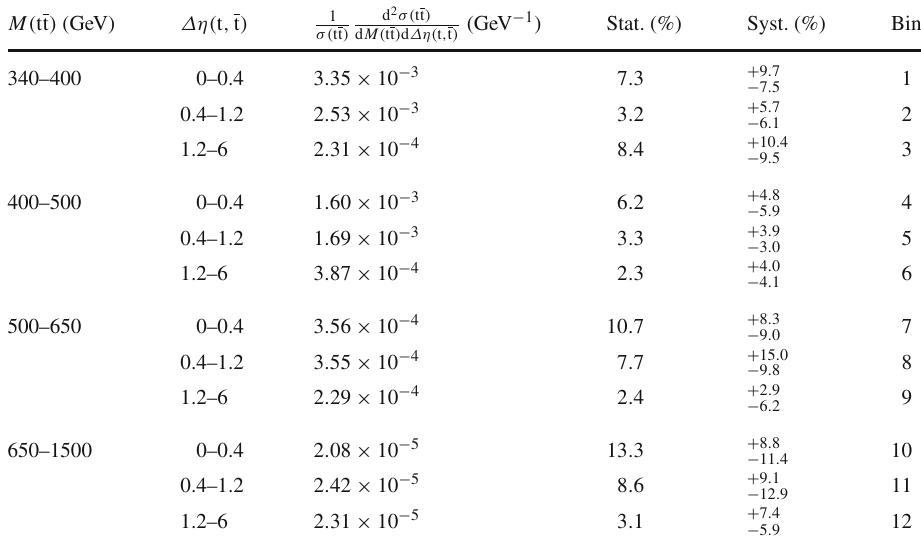
Table 14 The measured normalized tt double-differential cross sections in different bins of M ( tt ) and Δη( t , t ) , along with their relative statistical and systematic